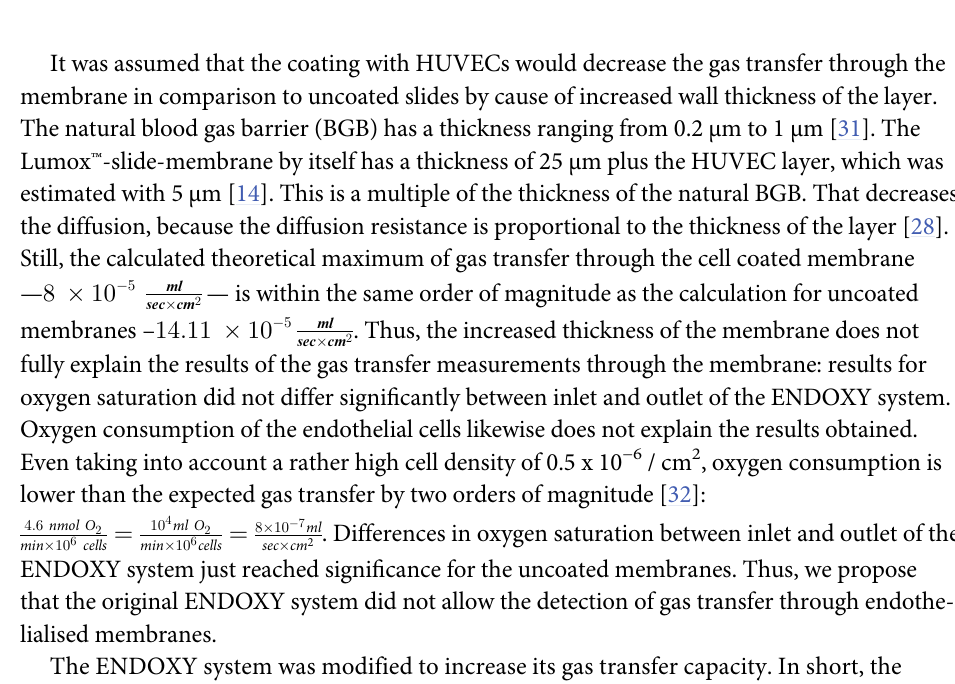
Table 8. Gas transfer of coated Lumox ™ slide after redesign. Flow rate Measured gas transfer ml